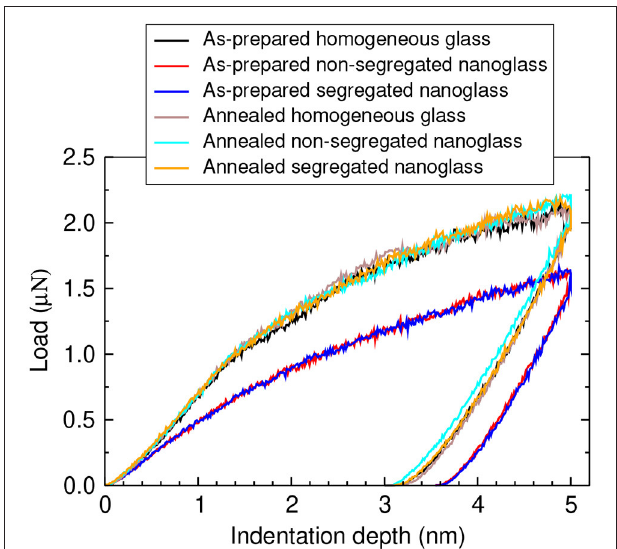
FIGURE 3 | P-h curves during nanoindentation of the as-prepared and annealed Cu 64 Zr 36 non-segregated and segregated nanoglasses. As-prepared and annealed homogeneous glasses with identical chemical composition are added for